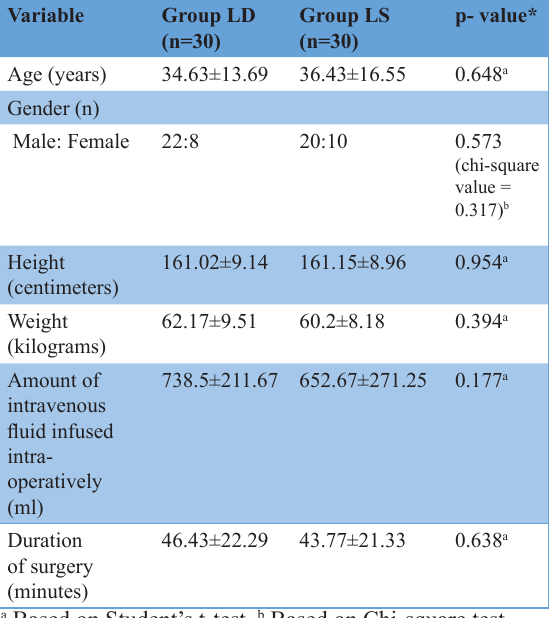
Table 1. Comparison of demographic variables between two groups